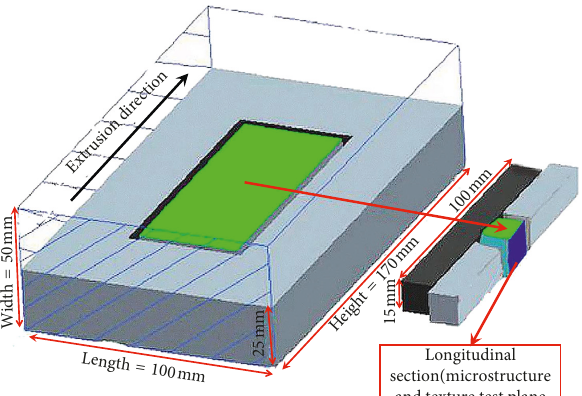
Figure 3: Schematic of sampling position in the deformed